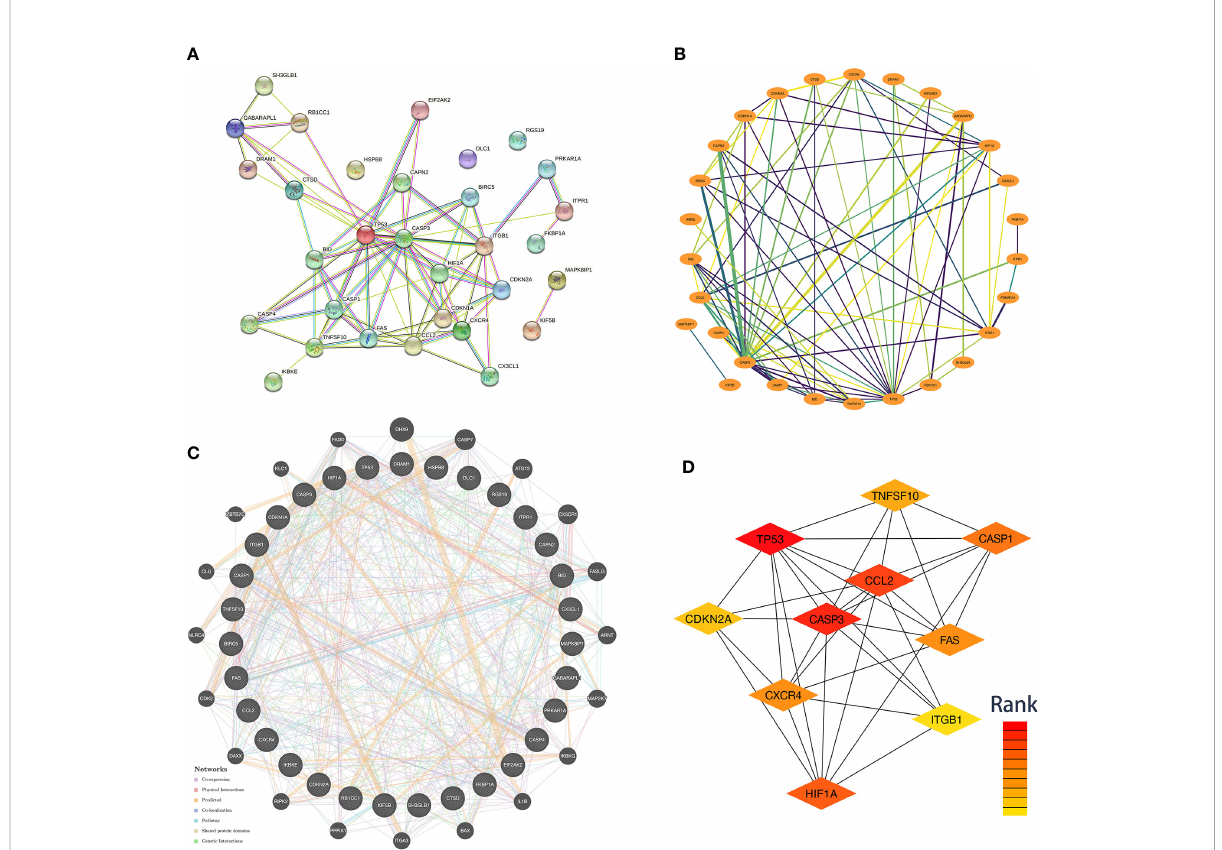
FIGURE 4 Co-expression network and identi fi cation of hub genes. (A) The PPI network between the differentially expressed autophagy-related proteins was established by using the STRING database. The node represents the protein, and the edge represents the relationship between the proteins. (B) The PPI network between the differentially expressed autophagy-related proteins was established by using Cytoscape with data from the STRING database. The edge width represents edge betweenness. The edge color represents combined score. (C) The top ten hub genes were screened by cytoHubba plugin. Nodes from red to yellow indicate descending rank. (D) The genetic interaction network between the differentially expressed autophagy-related proteins was established by using the GeneMANIA. PPI, protein-protein